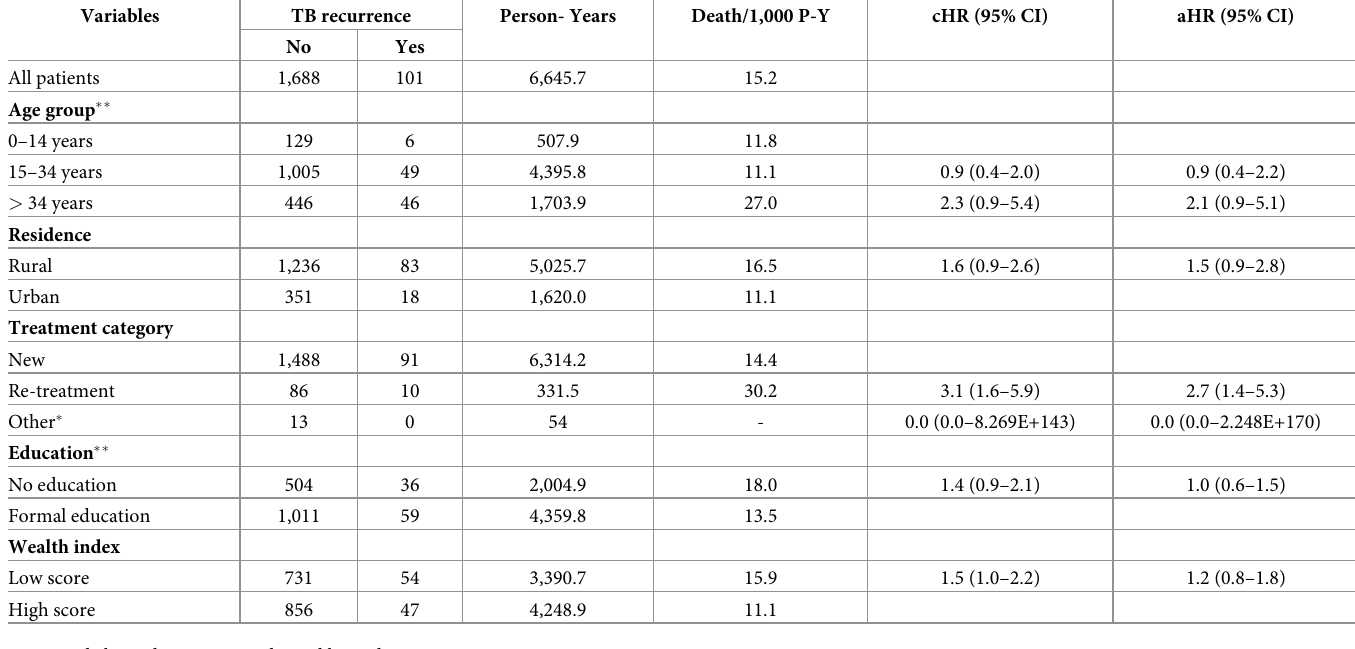
Table 2. Risk factors of TB recurrence among TB patients in Dale district in southern Ethiopia. Variables